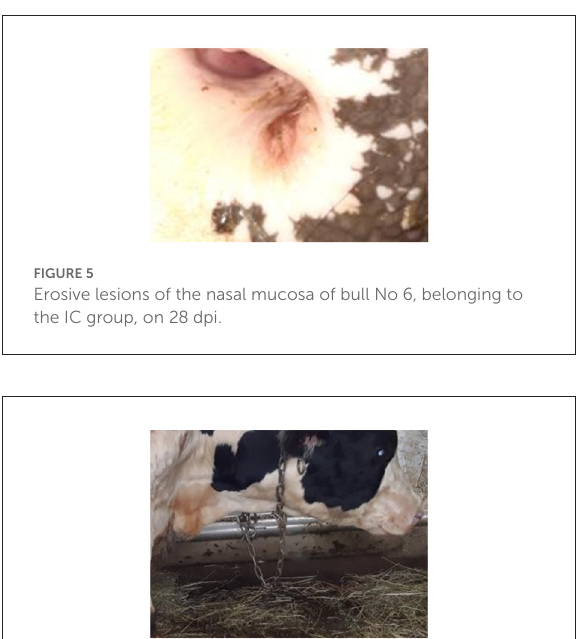
FIGURE6 Edema in the submandibular region of bull No. 4, belonging to the IC group, 30 dpi.